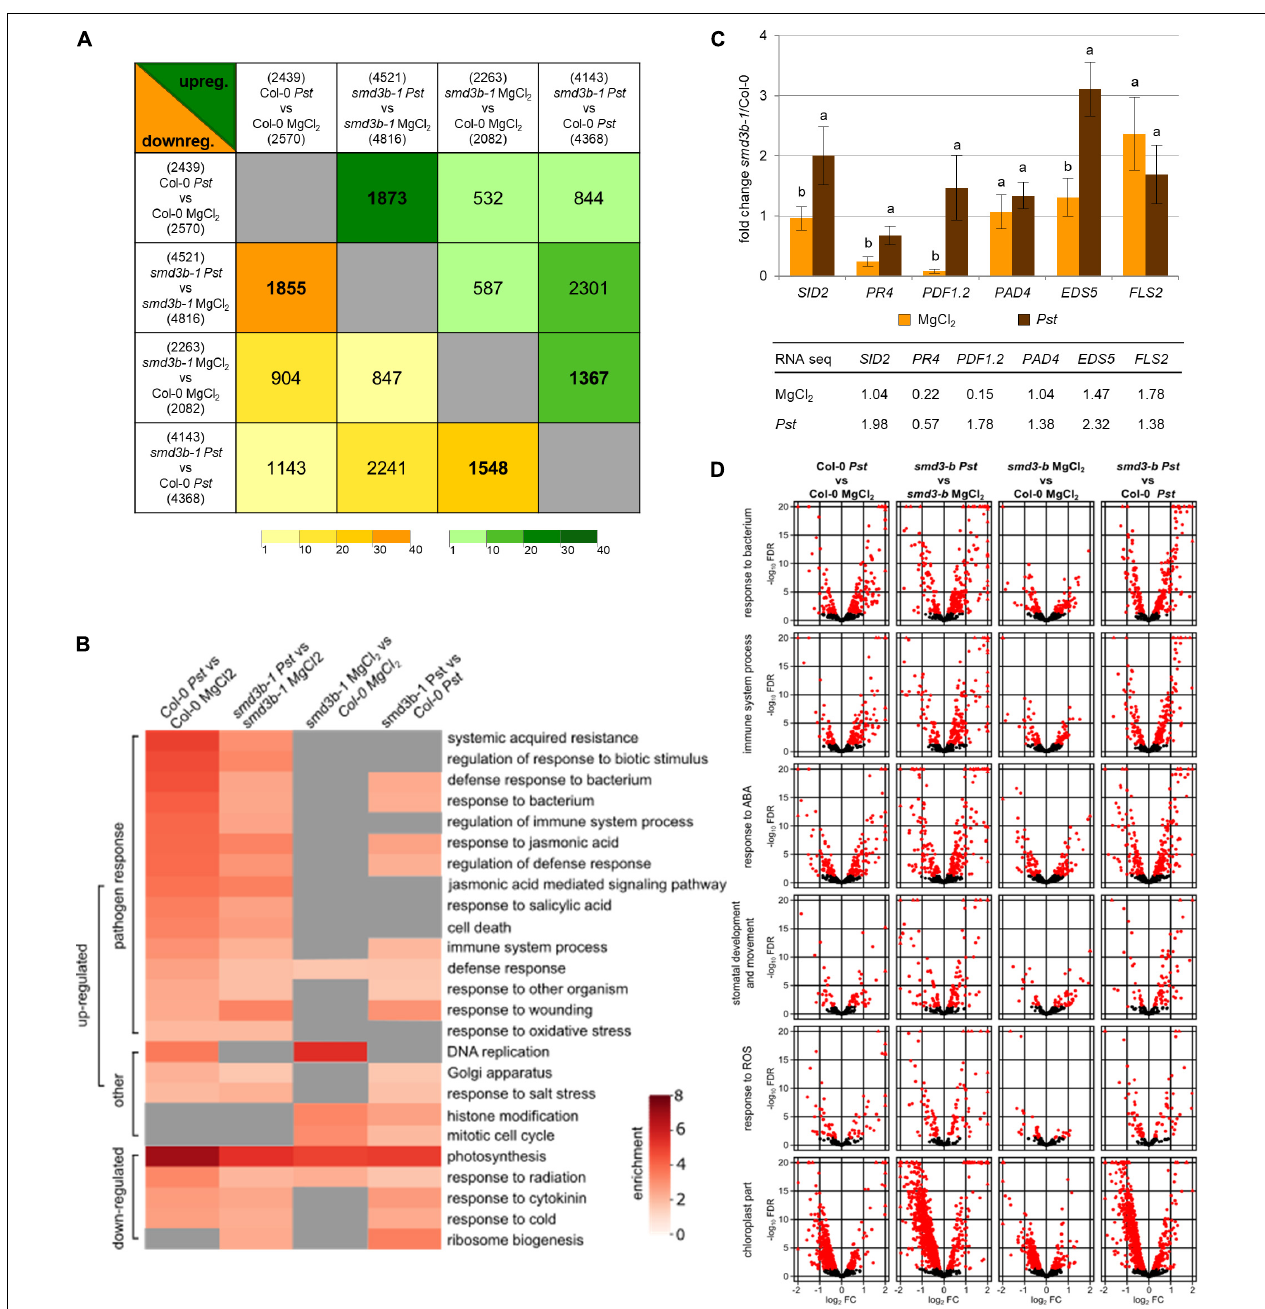
FIGURE 2 | Genes affected by Pst -infection and lack of SmD3-b. (A) Affected genes show high overlap between different comparisons. Comparison of genes with changed expression in RNA-seq data for control (MgCl 2 ) and infected (48 hpi; Pst ) Col-0 and smd3b-1 plants using odds ratio statistical test, which represents the strength of association between the two lists (odds ratio ≤ 1, no association; odds ratio >> 1, strong association). Number of genes with changed expression is shown above (upregulated) and below (downregulated) headings of each comparison; number of overlapping genes is shown in each cell for upregulated (green triangle) and downregulated (yellow triangle) genes, respectively. Color gradients mark for odds ratio calculated with GeneOverlap R package. (B) Genes with changed expression (FDR < 0.05) show enrichment in several GO categories (shown are only chosen categories, all results are in Supplementary Dataset 2 ). (C) Comparison of expression changes for selected mRNAs by RT-qPCR and RNA-seq. Plot show fold changes of transcript levels in smd3b-1 vs. Col-0 in control condition (MgCl 2 ) and 48 hpi ( Pst ). RT-qPCR values represent mean of three independent biological replicates with error bars showing standard deviations ( SD ); letters represent significant difference ( P < 0.05) for Tukey’s HSD test. UBC9 mRNA was used as a reference. Table presents analogous results from RNA-seq. (D) Bacterial infection and the smd3b-1 mutation impact gene expression in selected categories. Volcano plots (-log 10 FDR as a function of log 2 FC) for genes implicated in response to bacterium, immune system process, response to abscisic acid (ABA), stomatal development and movement, response to ROS and chloroplast part. Red dots and triangles mark genes with significant